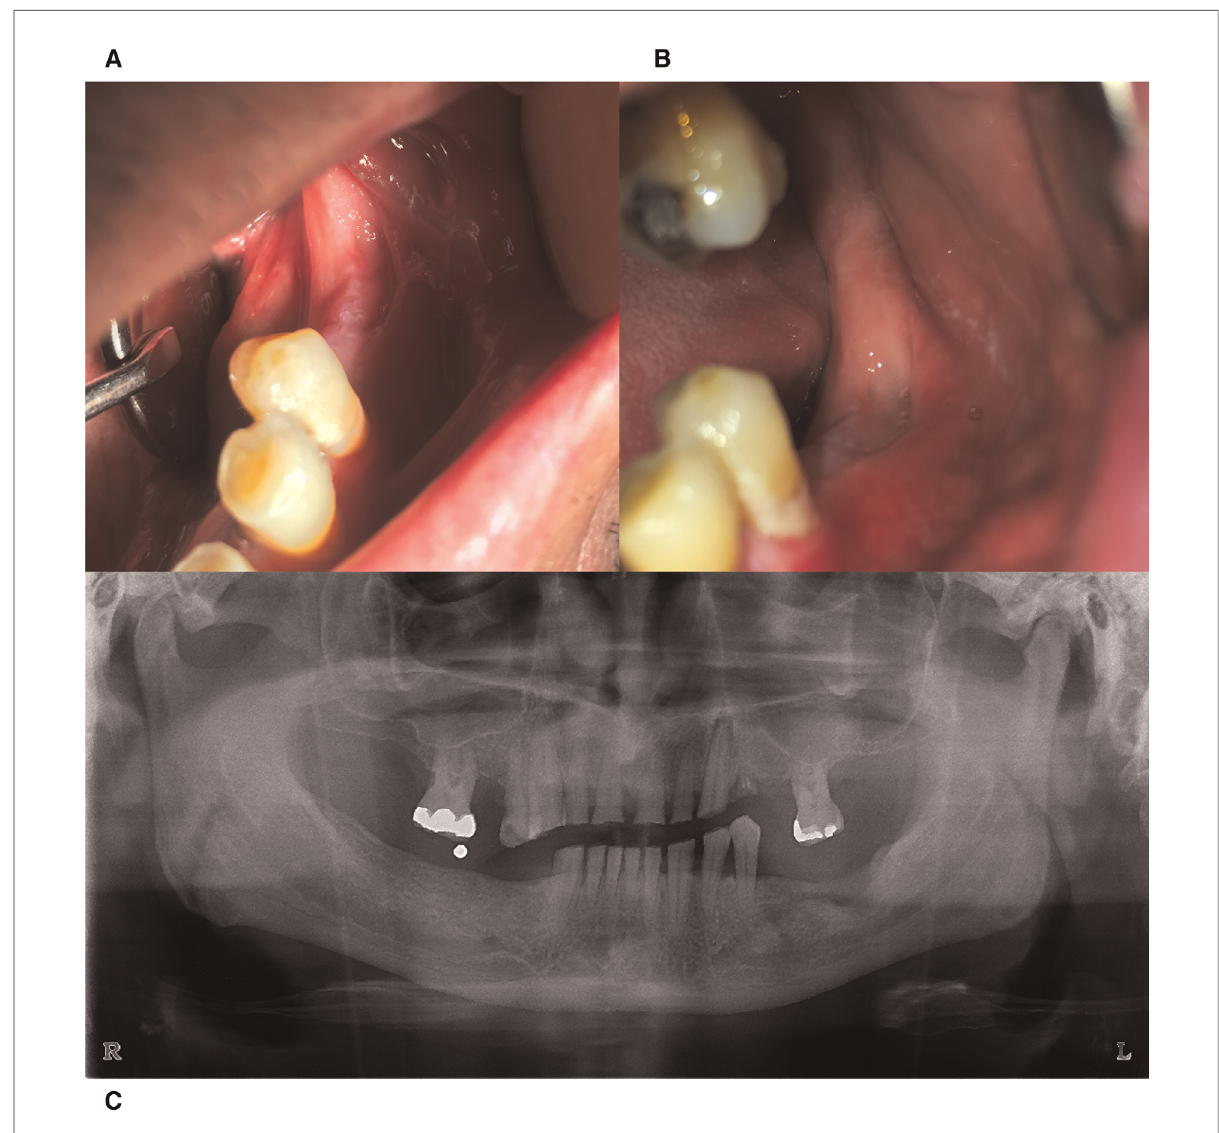
FIGURE 4 Clinical evaluation 3 months ( A ) and 6 months ( B ) postoperatively. ( C ) Radiographic image taken 6 months postoperatively with signs of bone